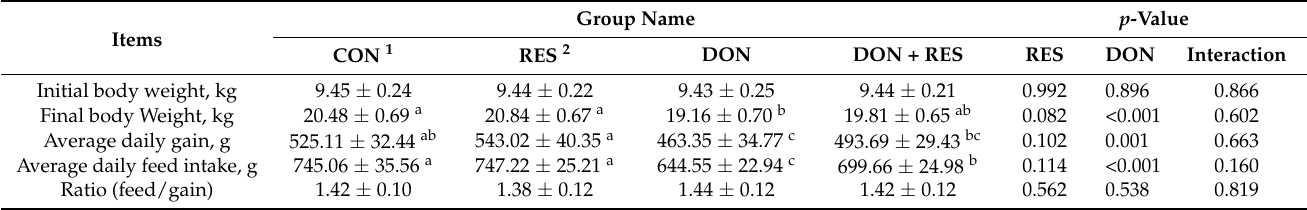
Table 3. The effects of RES (RES) on the growth performance of piglets.